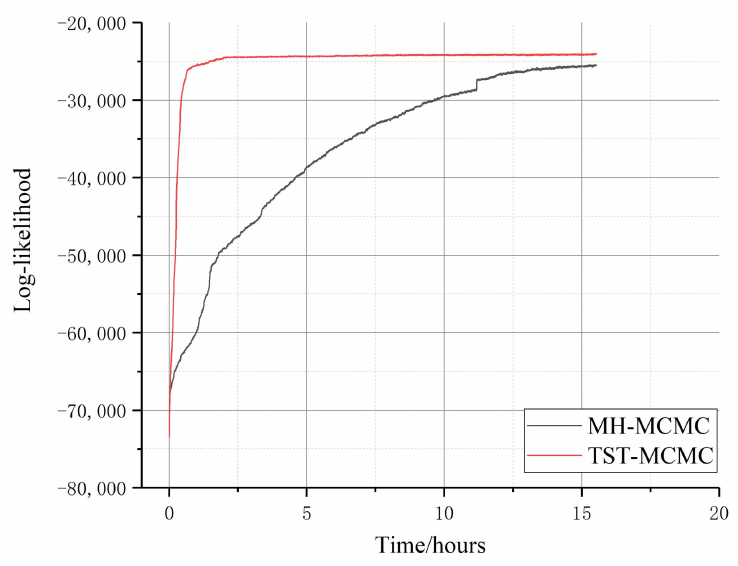
Figure 14. Comparison of two algorithms in protein interaction network (the function of likeli- hood logarithm with time; red represents TST-MCMC algorithm, and black represents MH-MCMC algorithm).